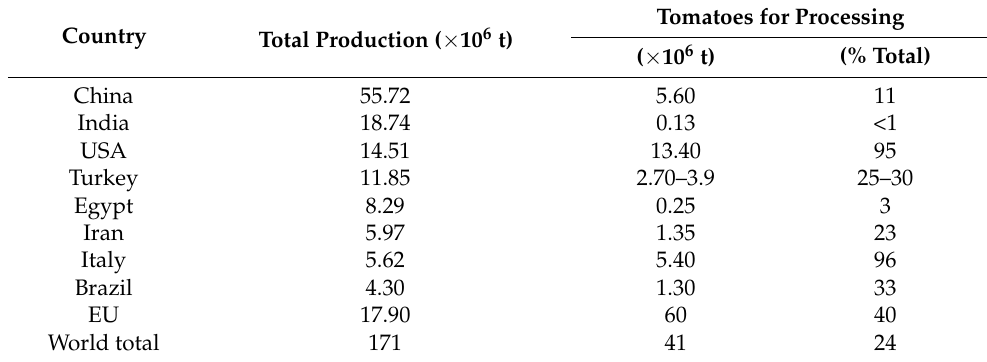
Table 2. The top ten tomato-producing countries. Annual data 2014–2016